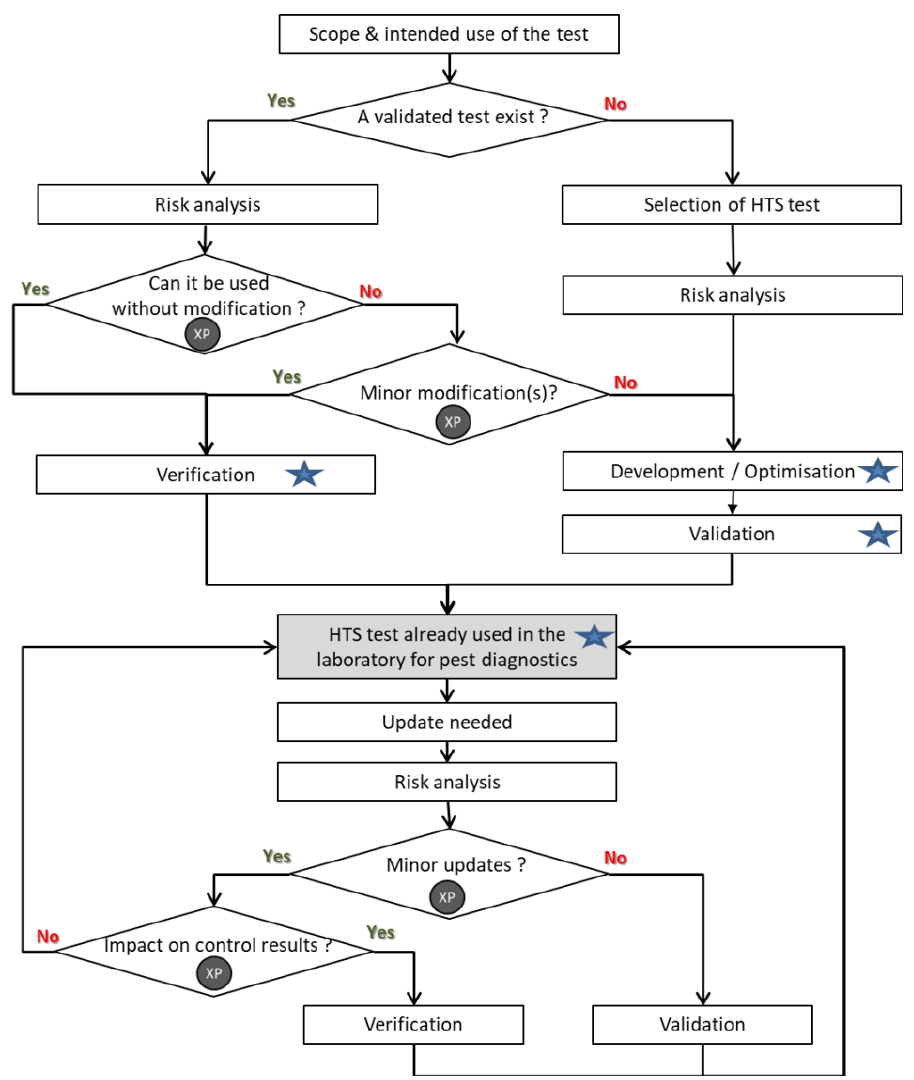
Figure 1: Decision tree related to the development, validation or verification of an HTS test and to the updates when used in routine diagnostics. The blue stars correspond to the steps where the use of reference material is needed. The grey circles with XP mean technological and scientific expertise